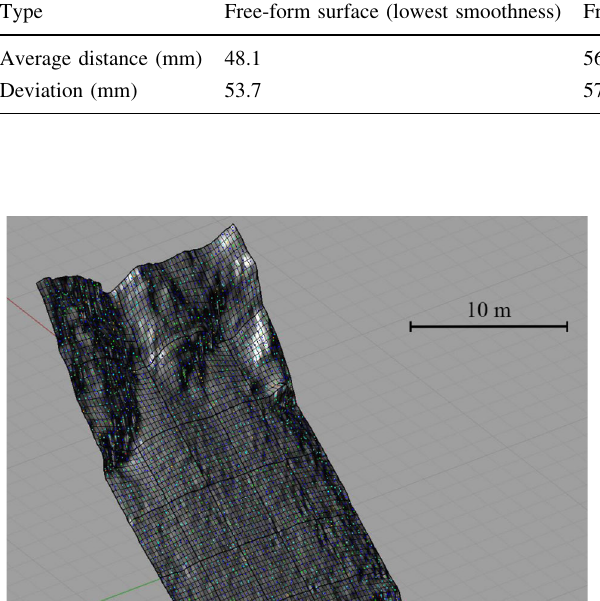
Table 7 Deviation of the planar and NURBS surfaces from the point cloud of Coc Sau Type